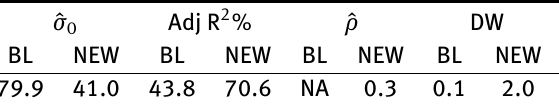
Table 4: A posteriori variance of unit weight, Adjusted R 2 , iteratively estimated first order autocorrelation coeflcient, and Durbin Watson statistics, DW, are listed for the baseline model (BL), new kinematic model (NEW). NA not applicable.